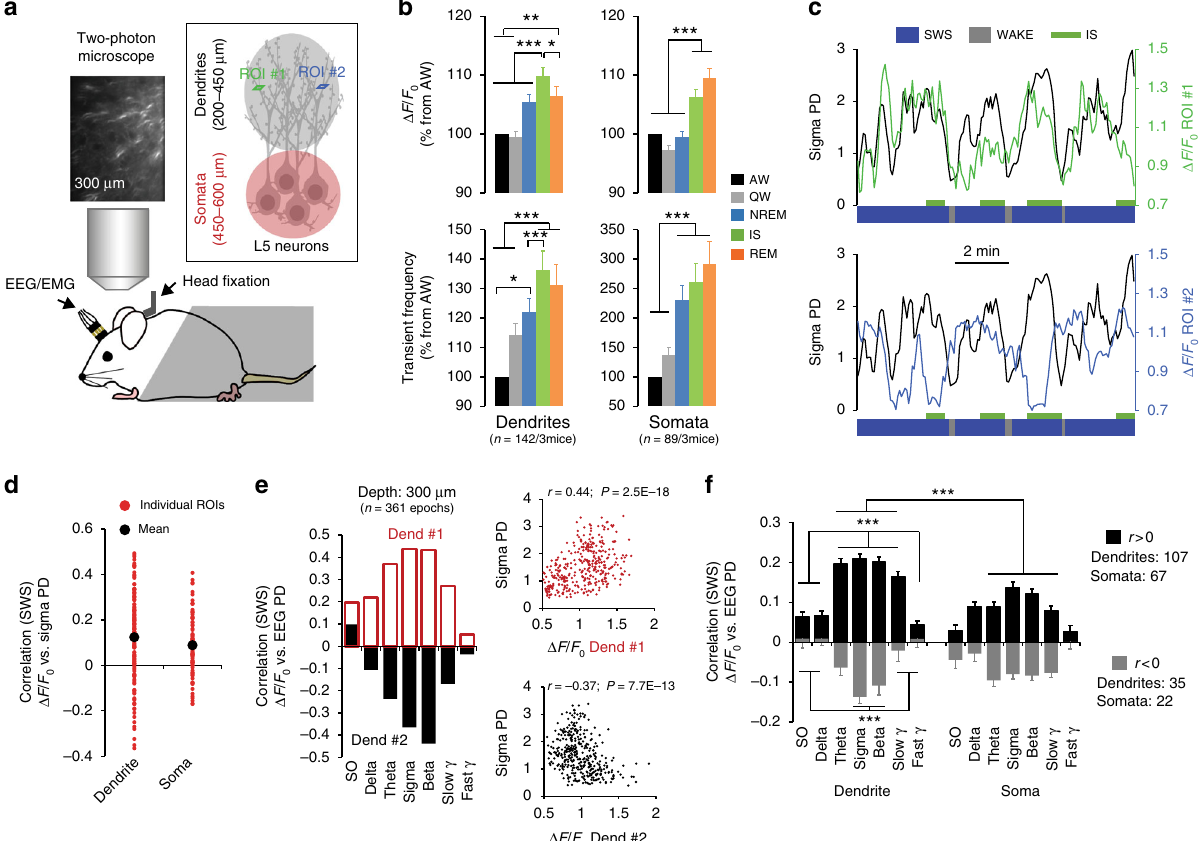
Fig. 5 Spindle – beta oscillations correlate with increased and decreased Ca 2+ activity in single dendrites. a Schematic of combined EEG recordings and two- photon Ca 2+ imaging of apical dendrites and somata of L5 neurons. b Mean ( ± s.e.m.) Ca 2+ activity ( Δ F / F 0 : upper graphs ; transient frequency: lower graphs ) across single dendrites ( left graphs , n = 143 dendrites in 3 mice) and single somata ( right graphs , n = 89 somata in 3 mice) for each behavioural state. Activity in individual dendrites and somata are expressed as percentage of change from respective activity during AW (one-way RM ANOVA; Dendrites: F 4,722 = 25.32; Somata: F 4,307 = 22.79; P < 0.001 for both groups, * P < 0.05, ** P < 0.001 and *** P < 0.01, Holm – Sidak test). c Examples of Ca 2+ Δ F / F 0 fl uctuations in regions of interest (ROIs) from two dendrites imaged simultaneously (depth: − 200 µ m, schematised in ( a )) and sigma PD. Note the reverse correlation trend. d Correlation (Pearson) between Δ F / F 0 for all single dendrites and somata and sigma PD during SWS. e Example of correlation (Pearson) coef fi cient between Δ F / F 0 and frequency bands (EEG-FP) for two individual dendrites recorded simultaneously at − 300 µ m below the pia ( n = number of SWS epochs used for correlation). Corresponding scatter plots for sigma PD is shown on the right . f Mean ( ± s.e.m.) correlation across dendrites and somata selected to have a positive ( r > 0) or negative ( r < 0) correlation with sigma PD. Dendrites show a stronger correlation with EEG changes compared to somata, especially for positive correlations (two-way ANOVA; factor “ group ” : r > 0: F 1,1218 = 59.71, P < 0.001; r < 0: F 1,371 = 1.56, P = 0.21; *** P < 0.001, Holm – Sidak test). Within groups, increase and decrease of Ca 2+ activity in single dendrites correlated with frequency bands surrounding